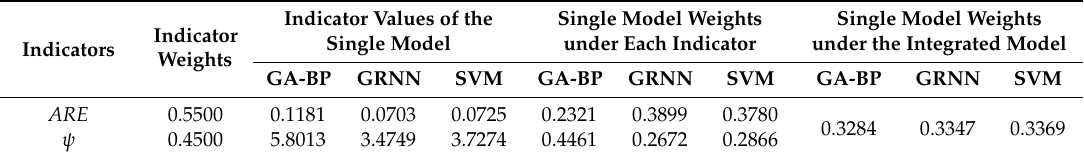
Table 1. Weight calculation for three single models and the integrated model. ARE : average relative error.